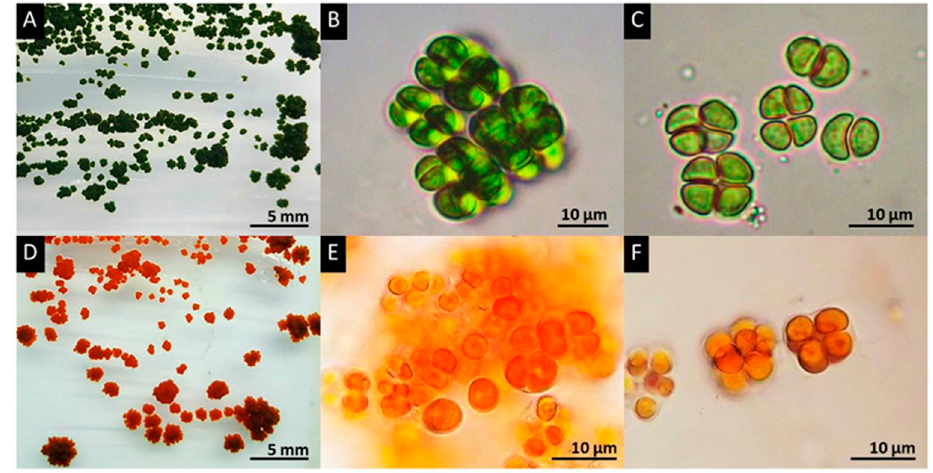
Figure 1. Morphologies of green and red cells of Chlorosarcinopsis PY02. ( A ) Green colonies on solid medium; ( B , E ) sarcinoid features formed by non-segregated vegetative cell division is seen in both green ( B ) and red cells ( E ); ( C ) the tetrad green cell stage; ( D ) Orange-red pigment accumulation resulting from secondary carotenoid accumulation appeared in red colonies on solid medium; ( E ) sarcinoid form in red cells; ( F ) tetrad red cells. PY02 was cultivated on TAP agar. ( A – C ) were taken on day 10. ( D – F ) were taken on day